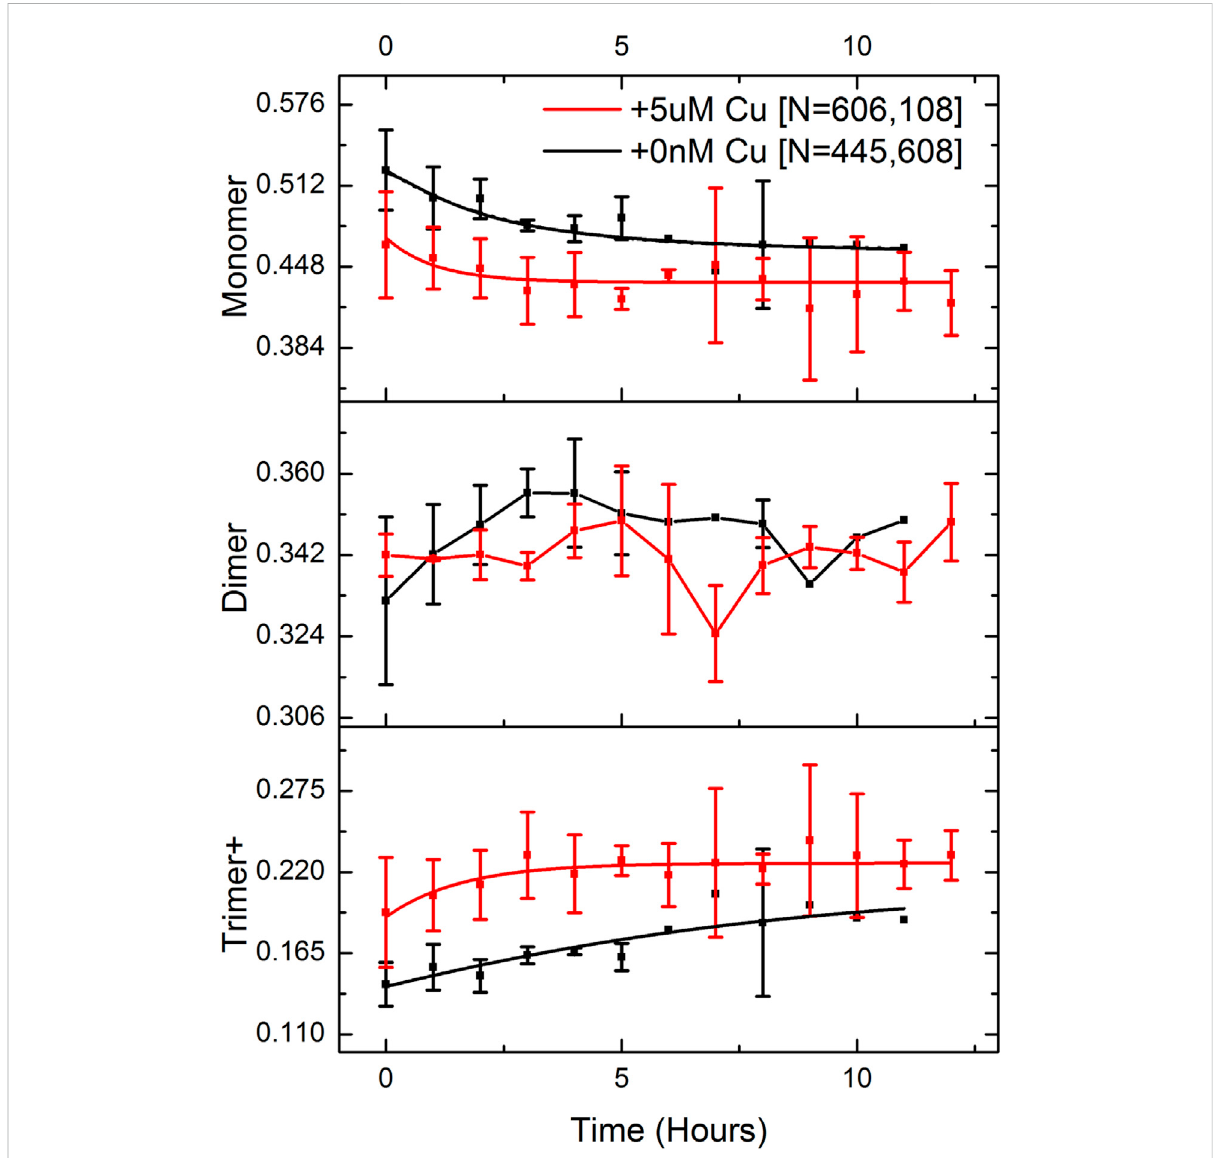
FIGURE 2 Kinetic pro fi les of A β aggregation are determined by single-molecule photobleaching analysis. 500 nM A β was incubated in the presence and absence of 5 µM Cu 2+ . Mass fraction instead of molar fraction in the Y -axis was used to better represent the relative population of oligomers. Oligomers with sizes larger than trimer were binned together with trimers and shown as “ Trimer+ “ . Three experimental repeats were carried out for each condition (+/- copper) and over 1 million single-molecule photobleaching traces were analyzed in